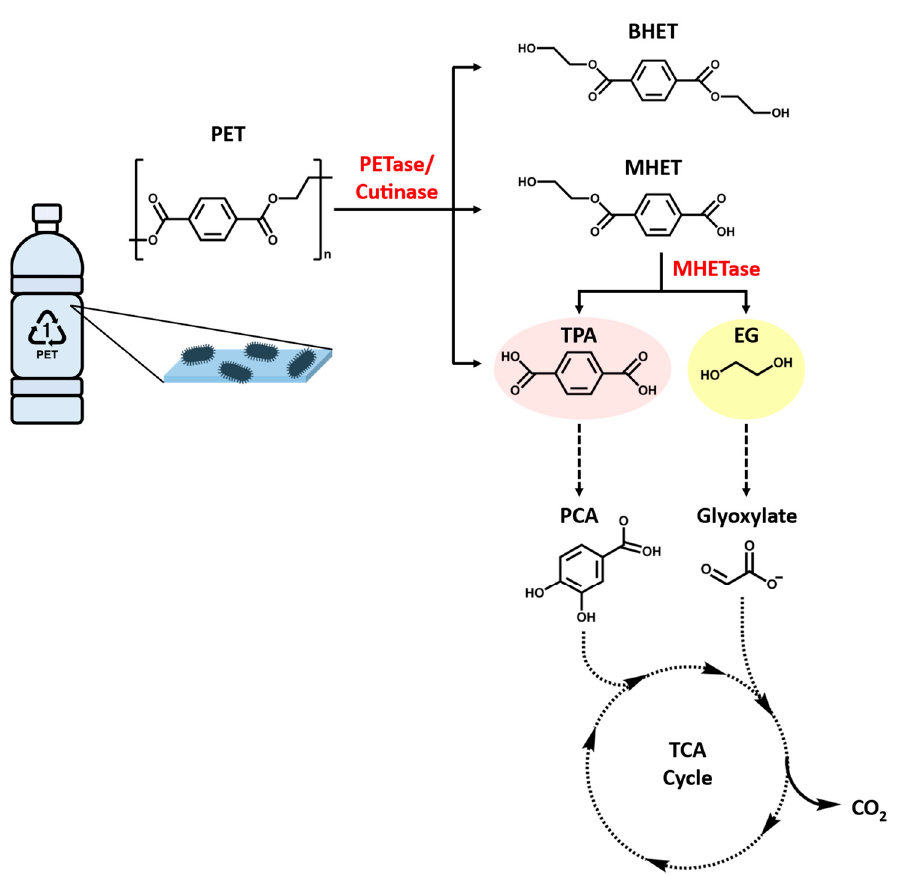
Figure 5. Microbial degradation of PET. PETase, PET hydrolase; MHETase, MHET hydrolase; BHET, bis(2-hydroxyethyl) terephthalic acid; MHET, mono(2-hydroxyethyl) terephthalic acid; TPA, terephthalic acid; EG, ethylene glycol; PCA, protocatechuic acid.